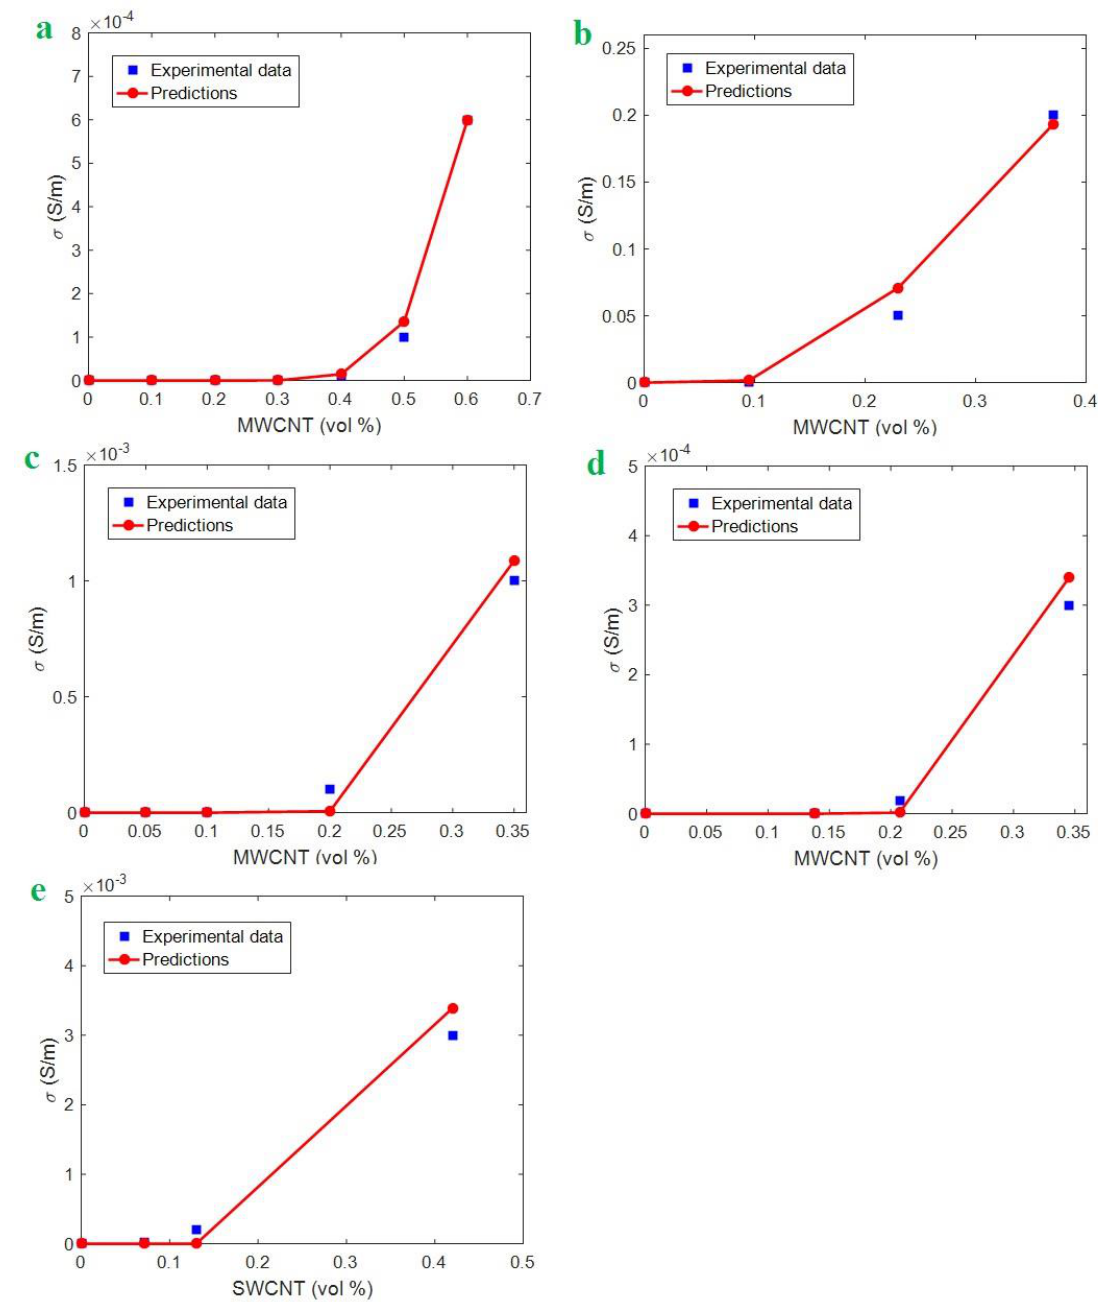
Figure 4. Experimental results of conductivity and the predictions of the developed model (Equation 11) for ( a ) polydimethylsiloxane (PDMS) / multi-walled CNT (MWCNT) [48], ( b ) ultra-high-molecular-weight polyethylene (UPE) / MWCNT [49], ( c ) poly (vinyl chloride) (PVC) / MWCNT [50], ( d ) poly (ethylene terephthalate) (PET) / MWCNT [51], and ( e ) epoxy / single-walled CNT (SWCNT) [52] nanocomposites.